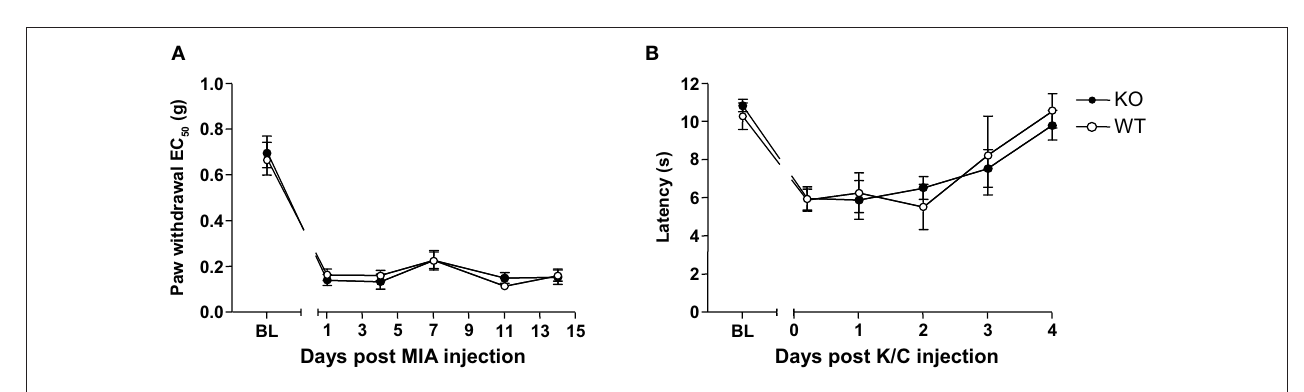
FIGURE 4 | Glra3 − / − mice show no differences in behavioural hypersensitivity in models of osteoarthritis or rheumatoid arthritis. (A) Signifi cant mechanical hypersensitivity was observed at all timepoints following unilateral intra-articular MIA (10 µl, 5 mg/ml) in both genotypes when compared with contralateral controls ( n = 6; p < 0.001). (B) Signifi cant thermal